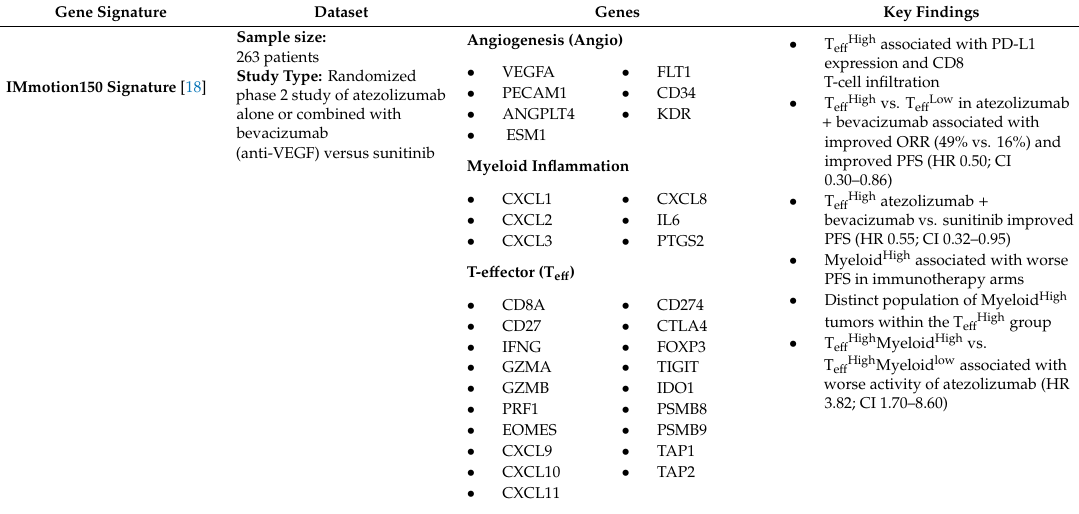
Table 2. Summary of gene expression